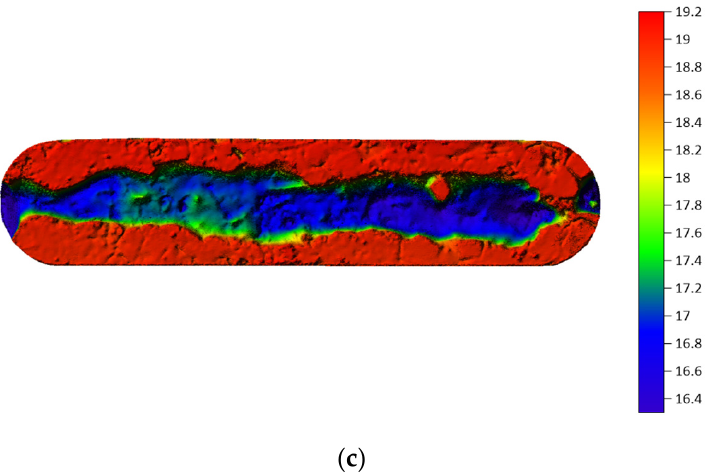
Figure 10. Characterization of the surface morphology of different slates after acid etching ( a ) pore type; ( b ) fracture-cavern type; ( c ) fracture-pore type.